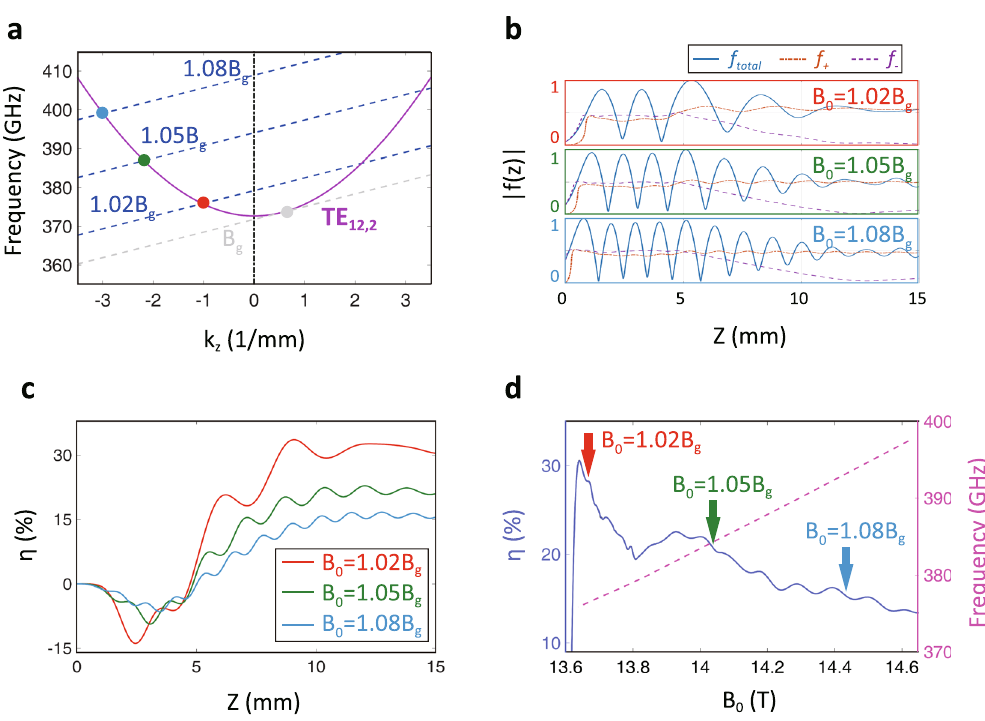
Figure 2. Analysis of broadband single-mode operation. ( a ) The cold dispersion relation between the TE 12,2 mode and three representative fundamental harmonic helical electron beam modes, corresponding to magnetic field strengths of 1.02 B g , 1.05 B g and 1.08 B g , respectively. B g is the magnetic field strength under tangential incidence with determined electron beam parameters. ( b ) The comparison of field profiles of the TE 12,2 mode in different magnetic field strengths. f total indicates the total wave, while f + and f − indicate the forward wave and backward wave, respectively. ( c ) The evolutionary process of electron beam efficiencies for three axial modes of the TE 12,2 mode. ( d ) The output efficiency in quasi-steady state and the continuous tuning range of the TE 12,2